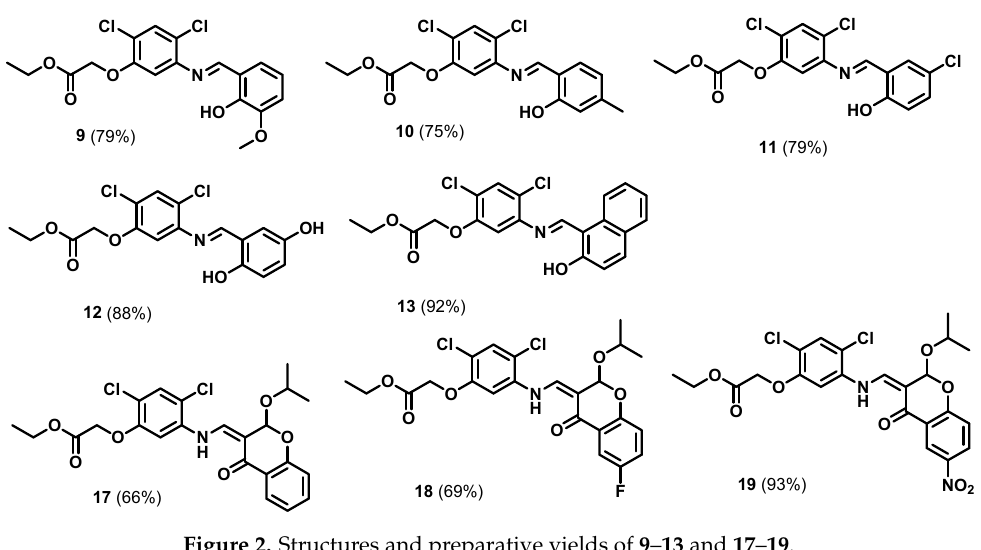
Figure 2. Structures and preparative yields of 9 – 13 and 17 – 19 .